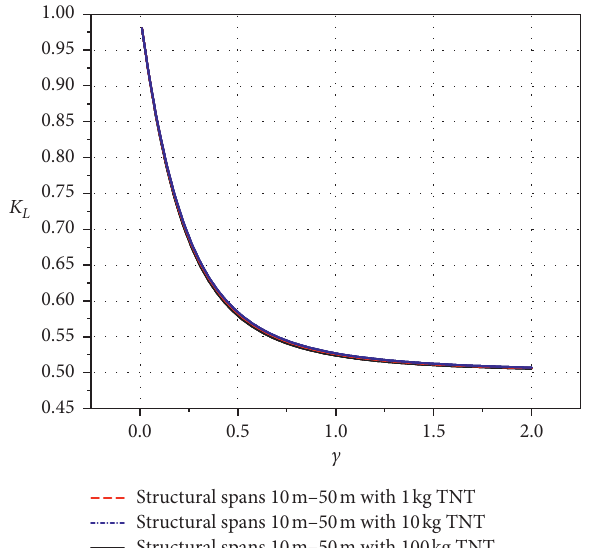
Figure 11: Equivalent load transformation factors of one-way members using Mills’ formula parameters in plastic